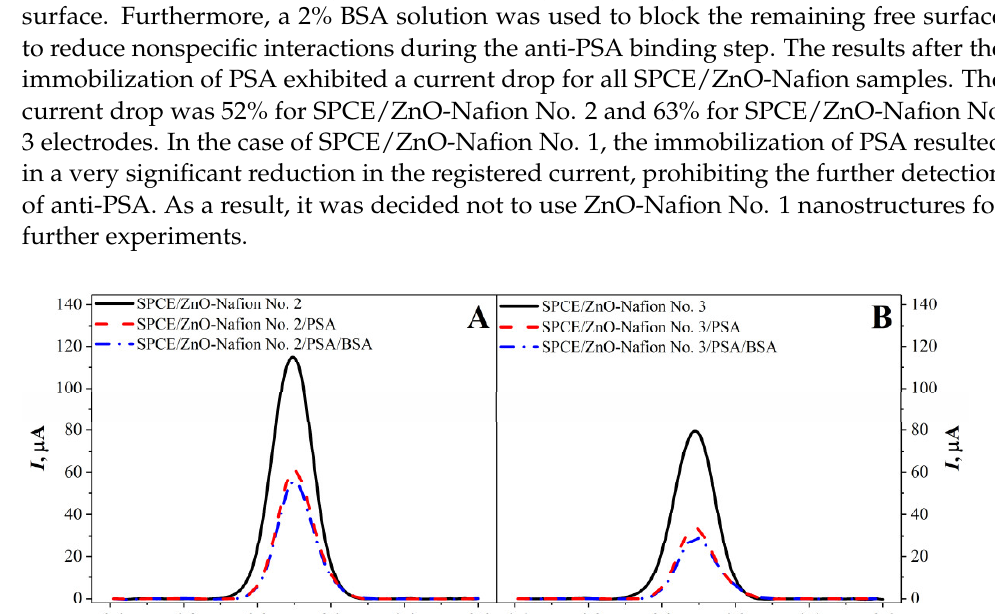
Figure 7. Differential pulse voltammograms of SPCE/ZnO-Nafion No. 2/PSA ( A ) and SPCE/ZnO- Nafion No. 3/PSA (after BSA blocking) ( B ) registered after interaction with different concentrations of anti-PSA. Potential range from −0.4 to +0.6 V with step size of 4 mV, pulse height of 0.05 V, pulse period of 100 ms, pulse width of 50 ms in 0.01 mM PBS, pH 7.4, containing 2.5 mM [Fe(CN 6 )] 3−/4− . The linear range, limit of detection (LOD), and limit of quantification (LOQ) for the proposed immunosensor were assessed using the data from the electrochemical experi- ments carried out, utilizing both SPCE/ZnO-Nafion No. 2/PSA and SPCE/ZnO-Nafion No. 3/PSA methodologies. The calibration curves are displayed in Figure 8. Immunosensors based both on ZnO No. 2 and ZnO No. 3 showed the same linear range from 10 to 50 nM of anti-PSA; however, the electrode modified with ZnO No. 2 showed a higher sensitivity for anti-PSA detection. The LOD was calculated as 3.3 σ/s and